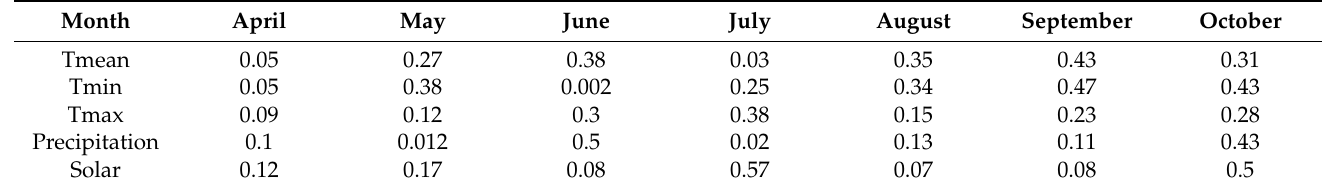
Table 3. The value R between tea NDVI and climatic factor in inter growing season from 2009 to 2018. Month